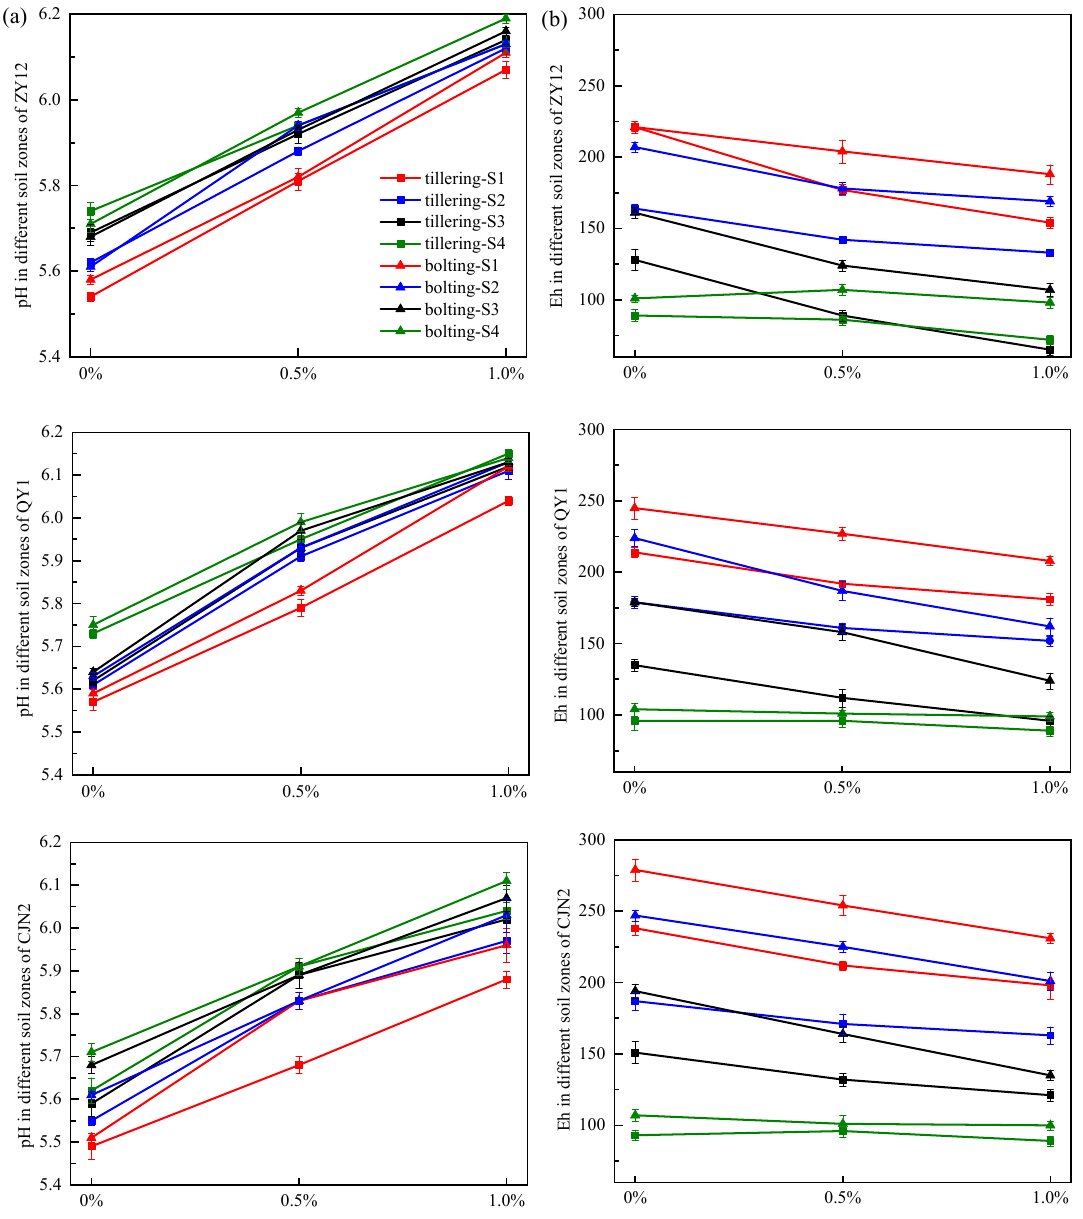
Figure 5. Effect of red mud (RM) on pH and redox potential (Eh) in different soil zones. ( a ) the pH value in soil; ( b ) Eh (Redox potential) in soil.